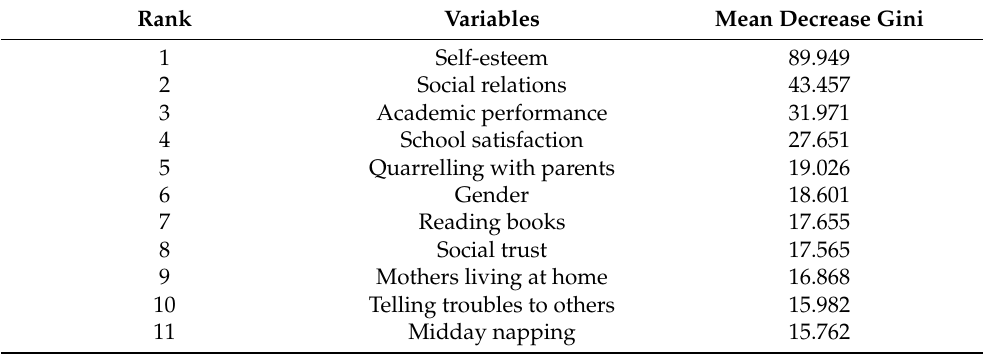
Table 4. The rank of importance of factors associated with subjective well-being (SWB) among Chinese adolescents in random forest